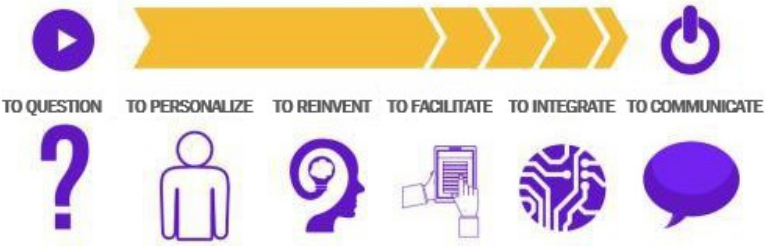
Figure 1. Steps of the transformation kit (Adapted from